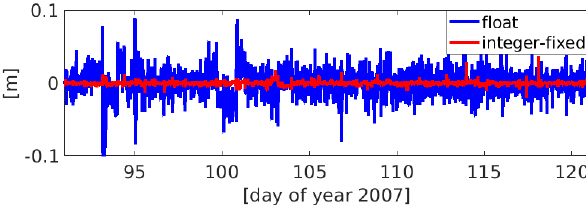
Figure 11. K-band range validation for one month of reduced- dynamic orbit fits of GRACE kinematic positions using epoch-wise covariances.